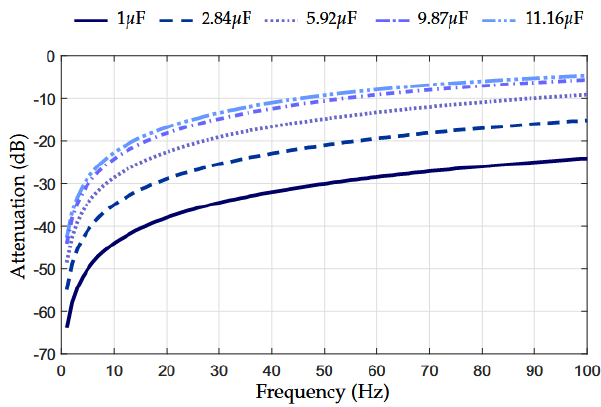
Figure 1. Attenuation profile of AC-blocking